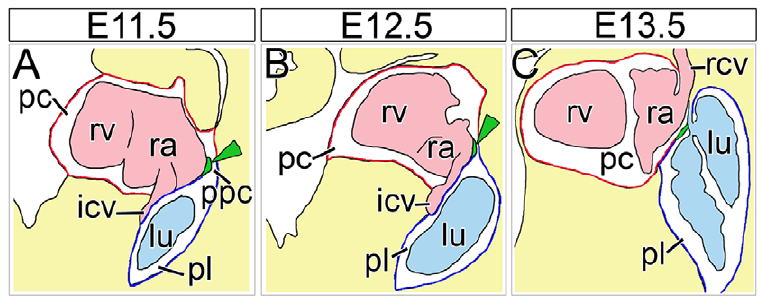
Figure 8. Schematic diagram of PPC closure in mouse development. (A–C) Scheme of PPC closure by sinuatrial mesenchymal ridges based on sagittal sections through the cardiac venous pole of wildtype embryos from E11.5 to E13.5. Sinuatrial mesenchymal ridges protrude into the PPCs at E11.5 and E12.5 and fuse with the overlying wall of the lung hilus at E13.5 to separate pleural and pericardial cavities. The lumen of the caval veins and the heart is marked in pale pink, the lung and trachea in pale blue, the mesenchymal sinuatrial ridges in green (additionally marked by green arrowheads), the (parietal) pericardium in red, the (parietal) pleura in dark blue and the double-walled PPMs in red and blue. icv; inferior caval vein; lu, lung; pc, pericardial cavity; pl, pleural cavity; ppc, pericardioperitoneal canal; ppm, pleuropericardial membranes; ra, right atrium; rcv, right superior caval vein; rv, right ventricle.